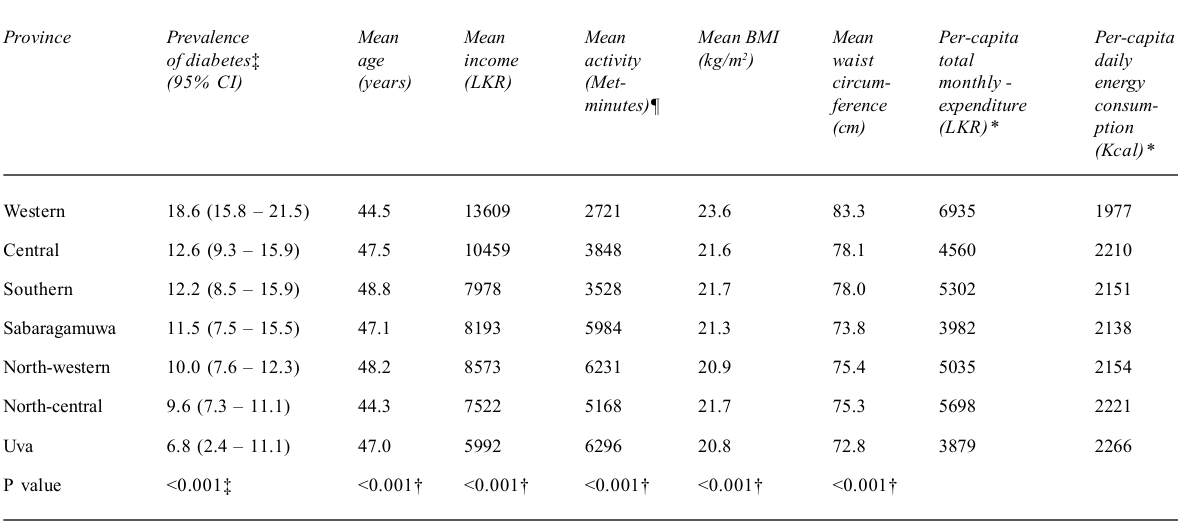
Table 1. Province specific prevalence of diabetes, risk factors and socio-demographic correlates